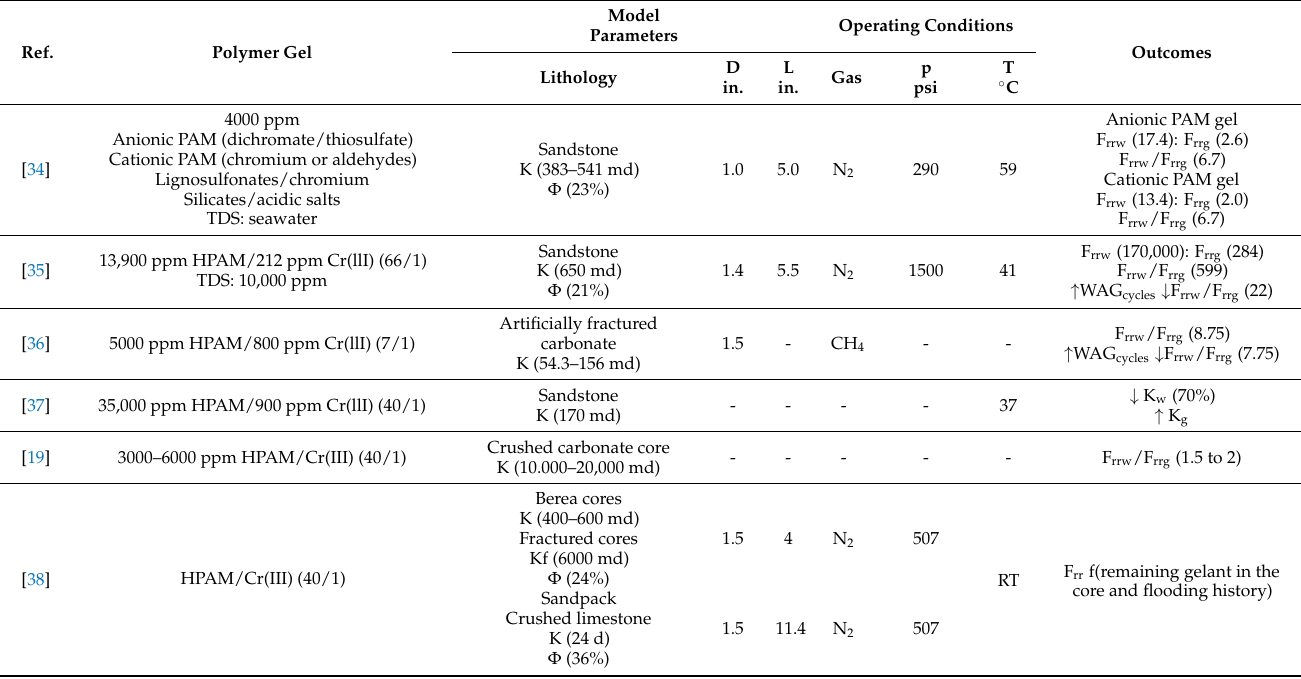
Table 1. Inorganically crosslinked polymer gels—lab evaluation.